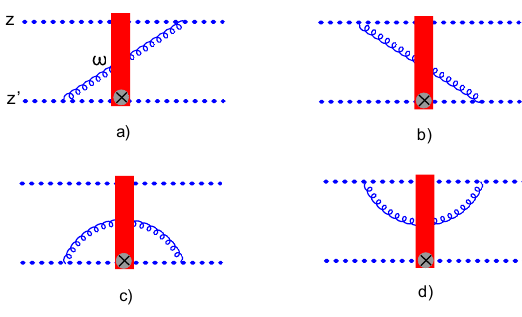
Figure 2. BK-type diagrams for the operator give in Eq.